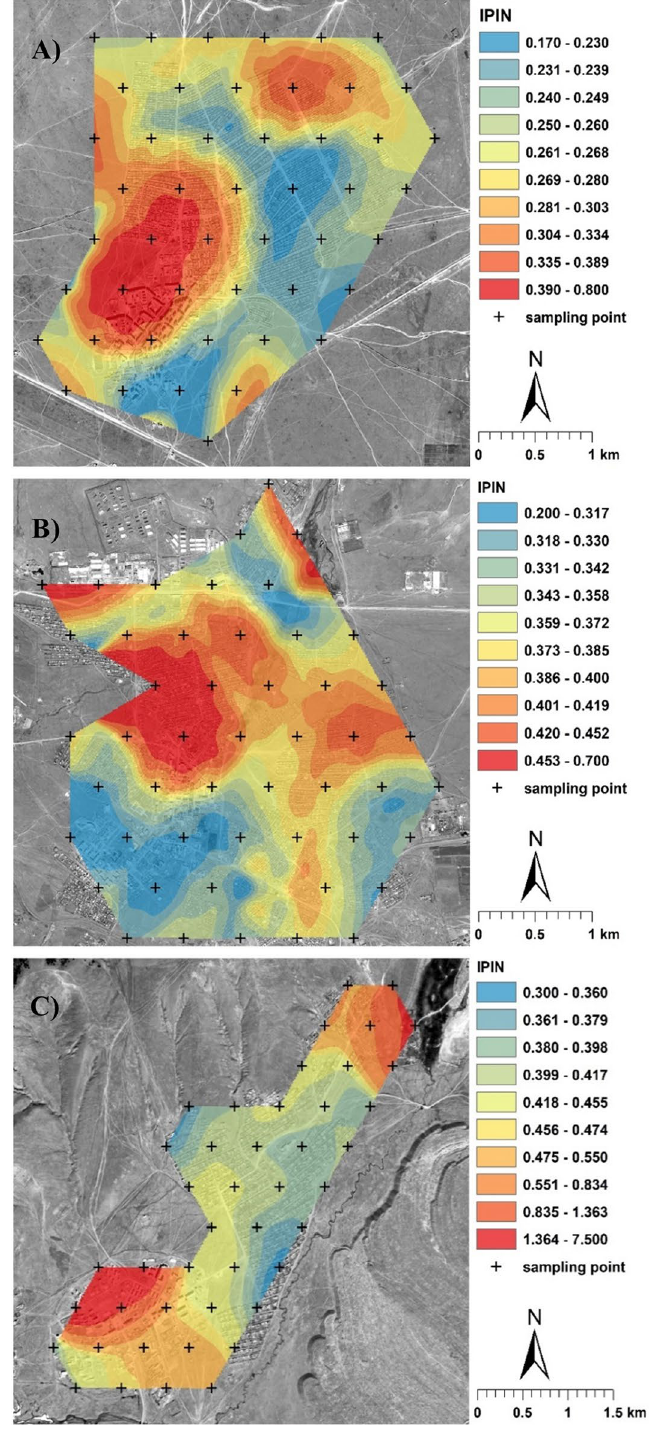
Figure 3. Integrated Nemerow Pollution Index (IPI N ) assessment-based pollution distribution in the coal mining towns: ( A ) Baganuur, ( B ) Nalaikh, and ( C ) Sharyn Gol. ArcGIS Desktop 10.8 software (Esri, CA, USA; https:// www. esri. com/ en- us/ arcgis/ produ cts/ arcgis- deskt op) was used to create the map. The layers of satellite imagery were generated using Esri World Imagery